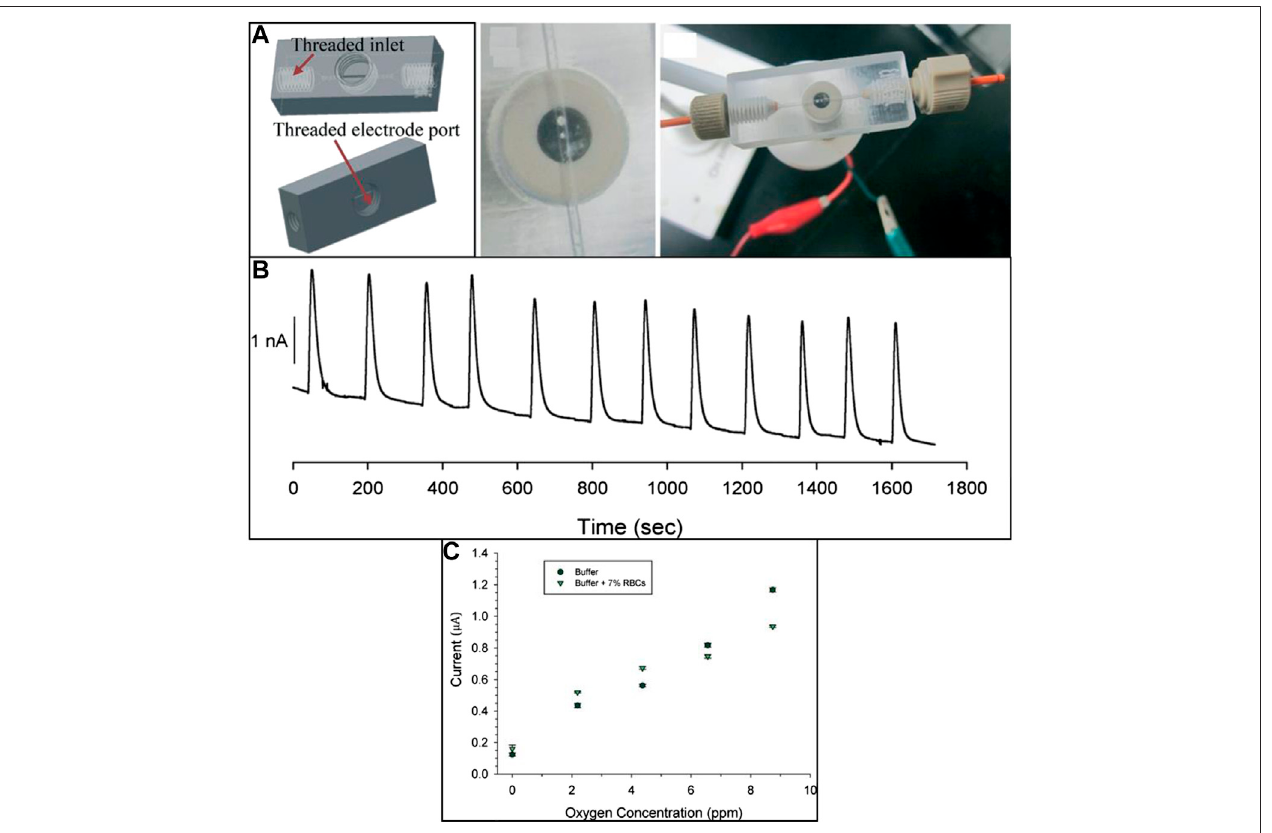
FIGURE 5 | (A) 3D-printed device with 0.5-mm wide micro fl uidic channels designed for the electrochemical detection of dopamine, nitrous oxide, and oxygen concentration. (B) Amperogram of reproducible 190 μ M NO injections over the Pt/Pt – black electrode. (C) Calibration curve data for oxygen standards in the buffer and the presence of RBC (reproduced with permission from Erkal et al.,